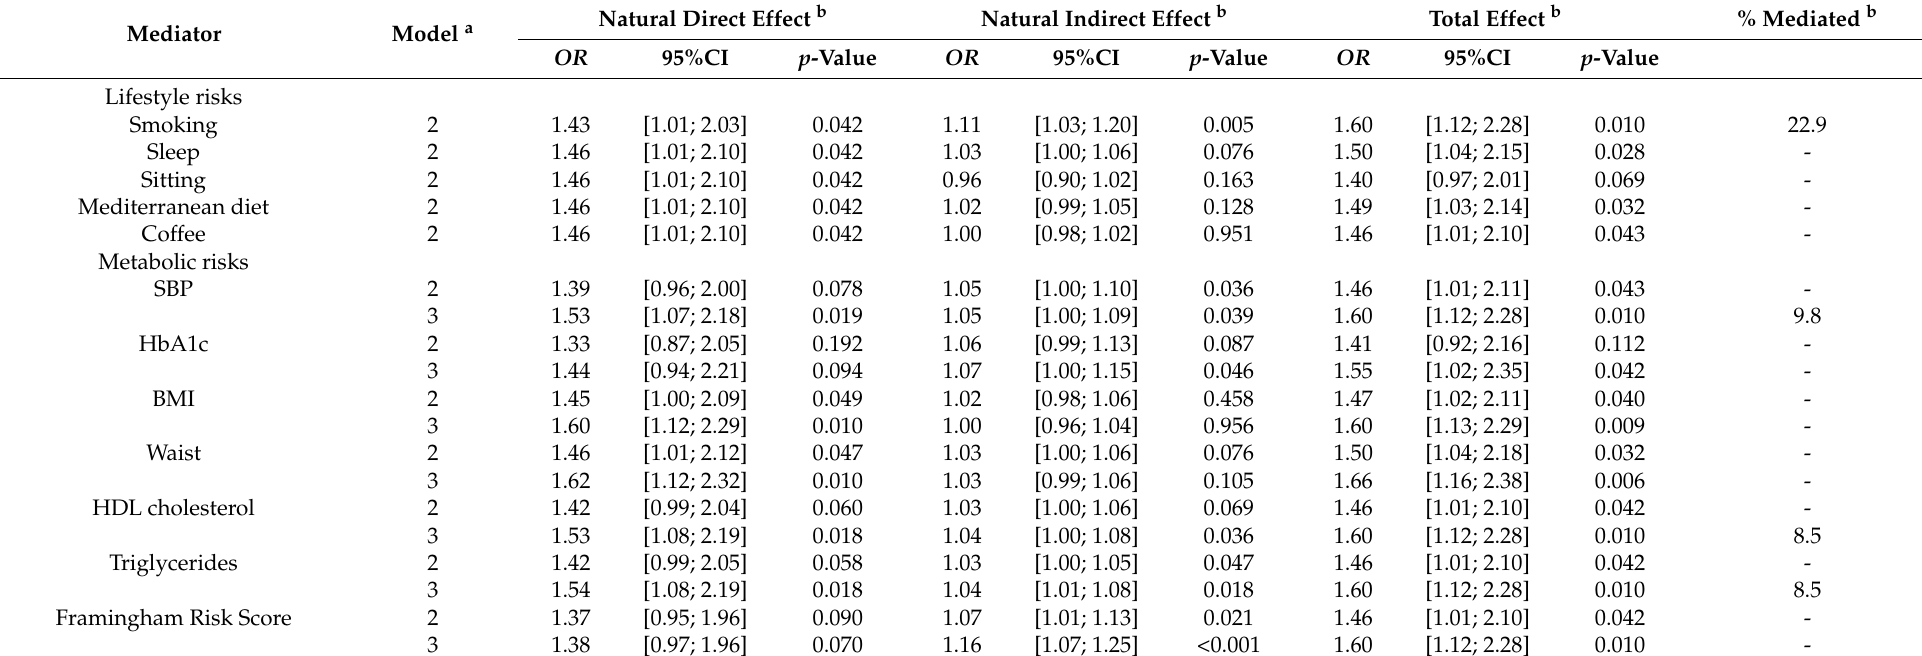
Table 4. Estimation of the mediation effect of lifestyle and biological risk factors in the association between work shift (Morning-Evening-Night versus central shift) and the presence of subclinical